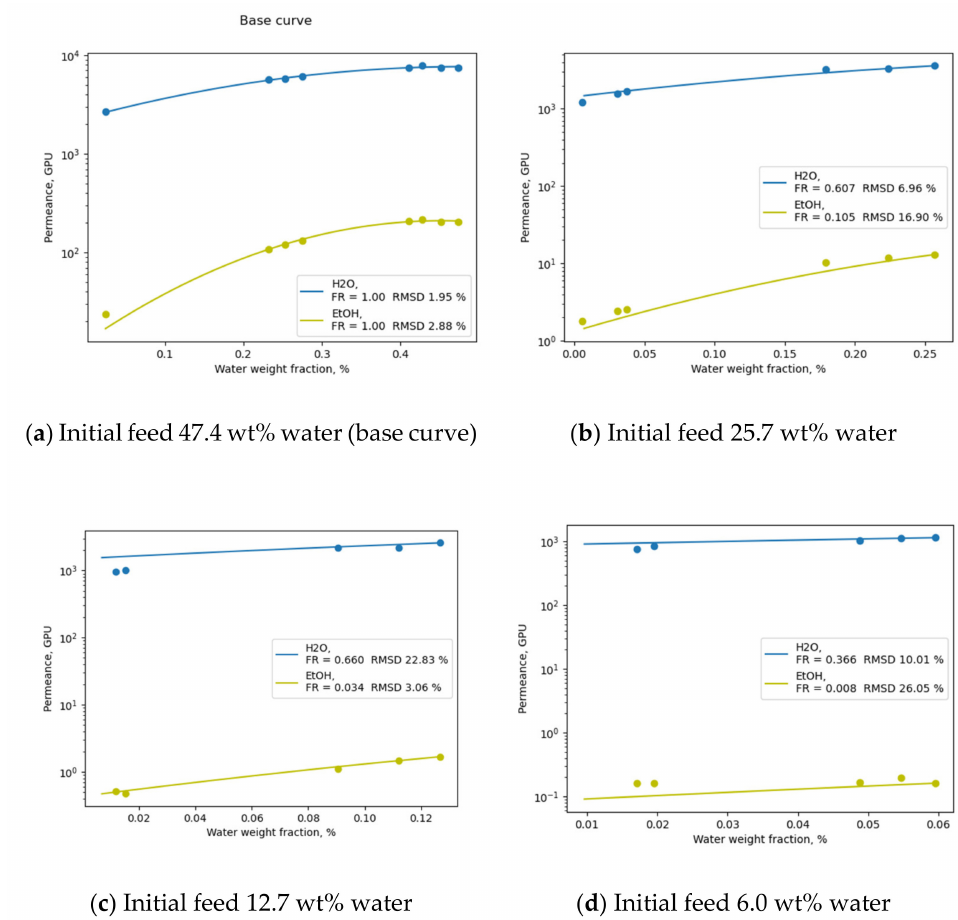
Figure 2. Illustration of the Pervap 4100™ [24] diffusion curve fit ( a ) with Equation (13) (initial water content 47.4 wt%) and modelled curves obtained by the introduction of the FR parameter ( b – d